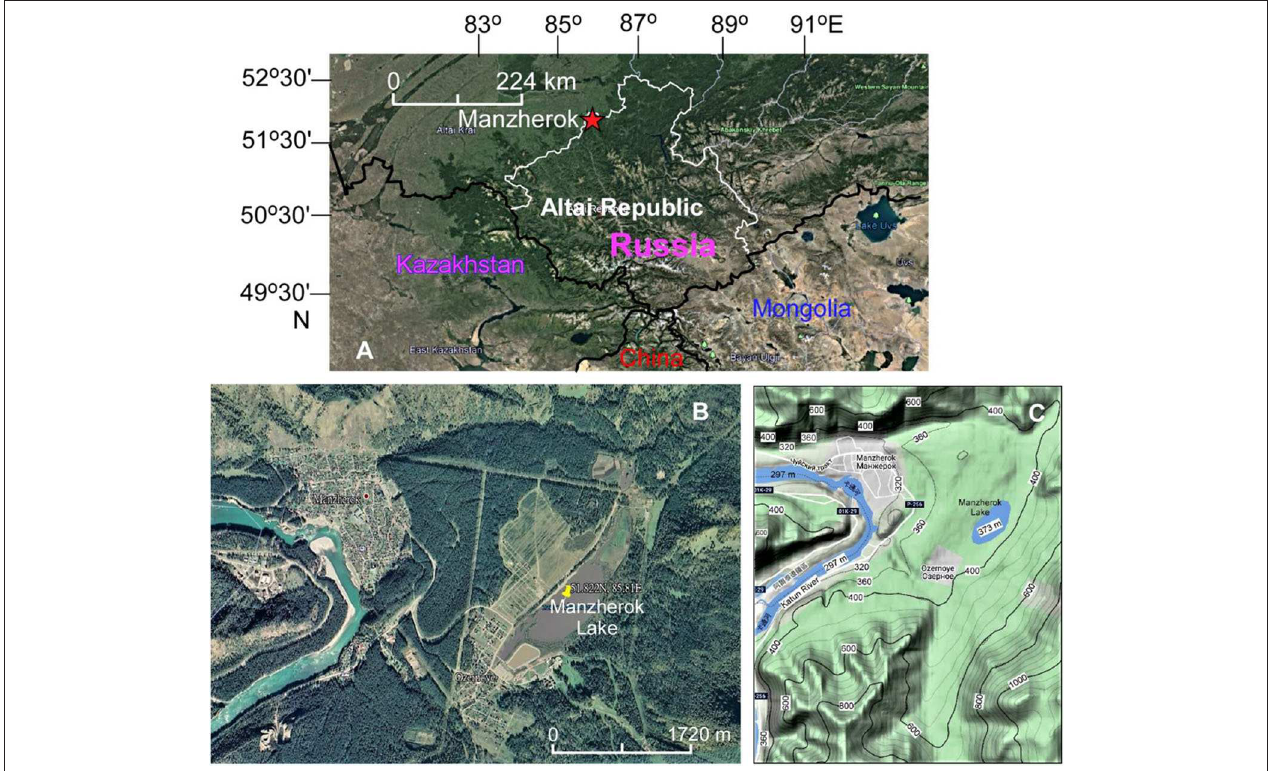
FIGURE 1 | Location of the study area. (A) Map of Altai and the surrounding areas. (B) Satellite map of the Manzherok area. (C) Topographic map with contour lines of the Manzherok area. The figures are modified from maps that have been downloaded from Google Map.